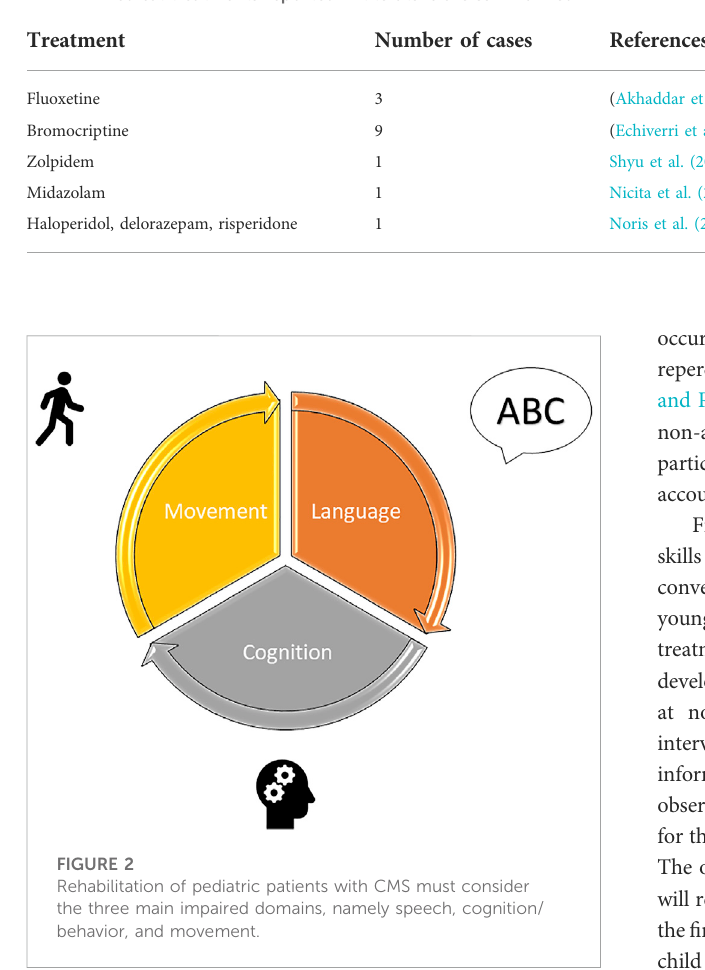
TABLE 2 Medical treatments reported in literature are summarized.